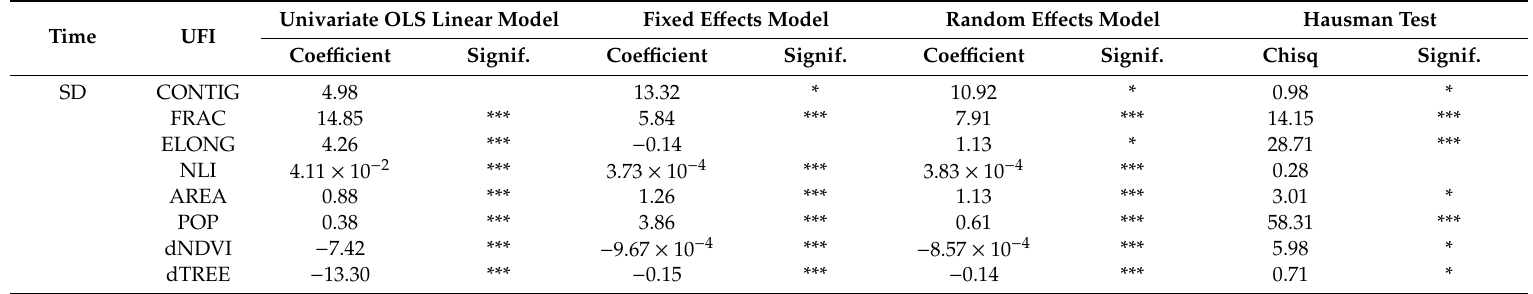
Table A2. Results of regression models and the Hausman